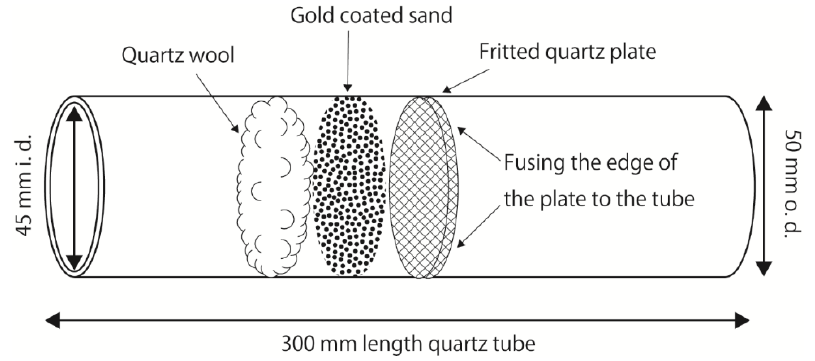
Figure 1. A schematic of the large gold-coated sand trap (BAuT).